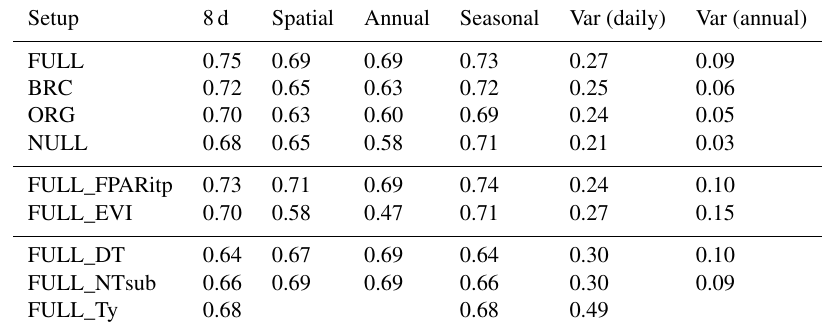
Table 3. R 2 of simulated and observed GPP based on different model setups and for different components of variability. Setup Spatial